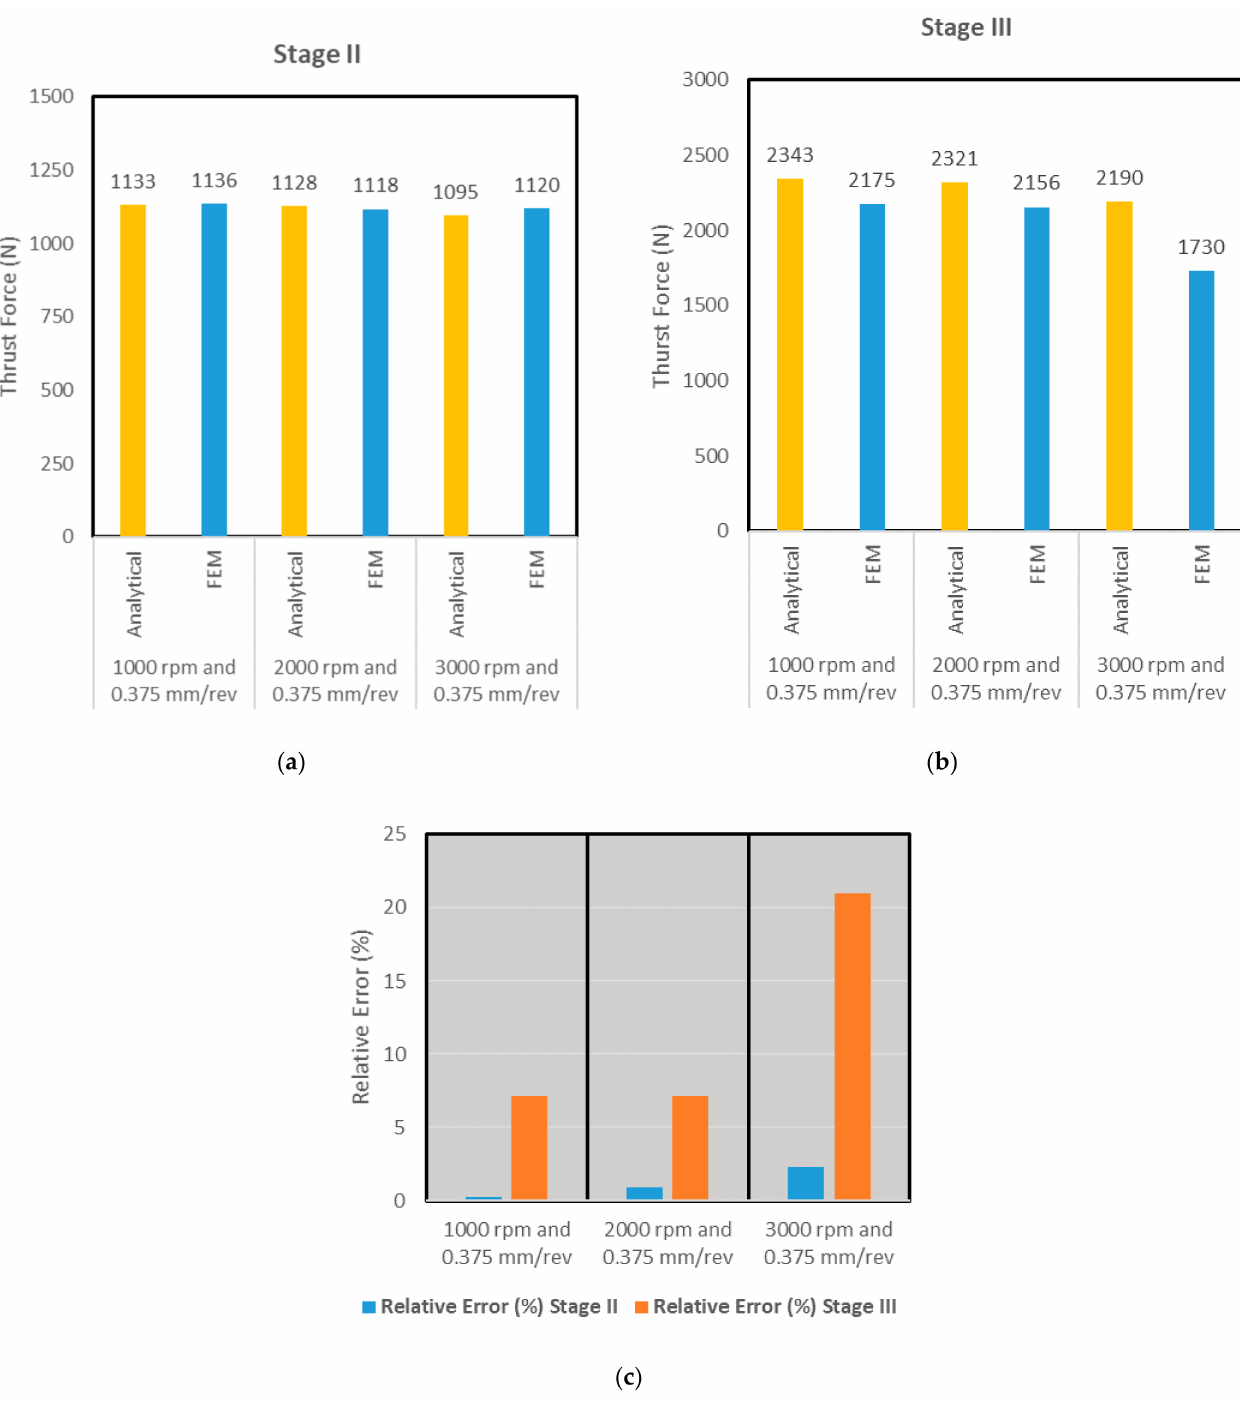
Figure 18. ( a ) Stage II: Average thrust forces in analytical and FEA approaches ( b ) Stage III: Average thrust forces in analytical and FEA approaches ( c ) Relative error % in both